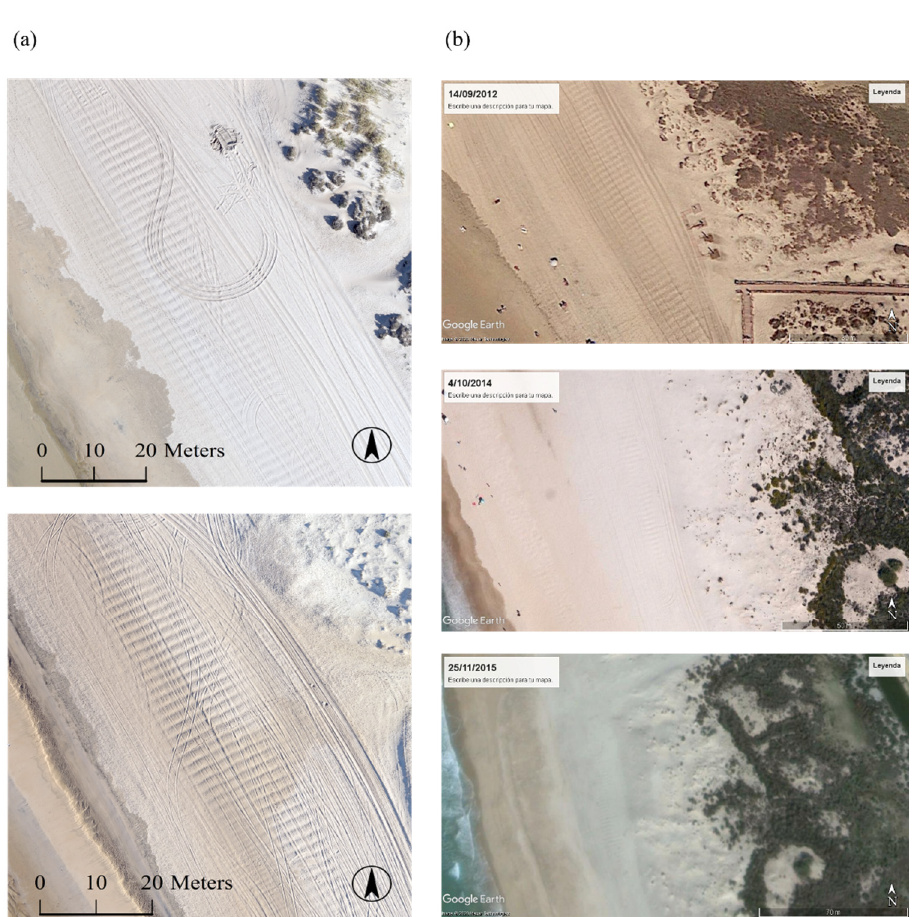
Figure 2. ( a ) Unmanned aerial systems (UAS)-derived mosaics showing the general geometry of the rhythmic features in the beach sectors were they were more prominent, ( b ) Google Earth imagery (2012, 2014, and 2015) showing similar rhythmic features.